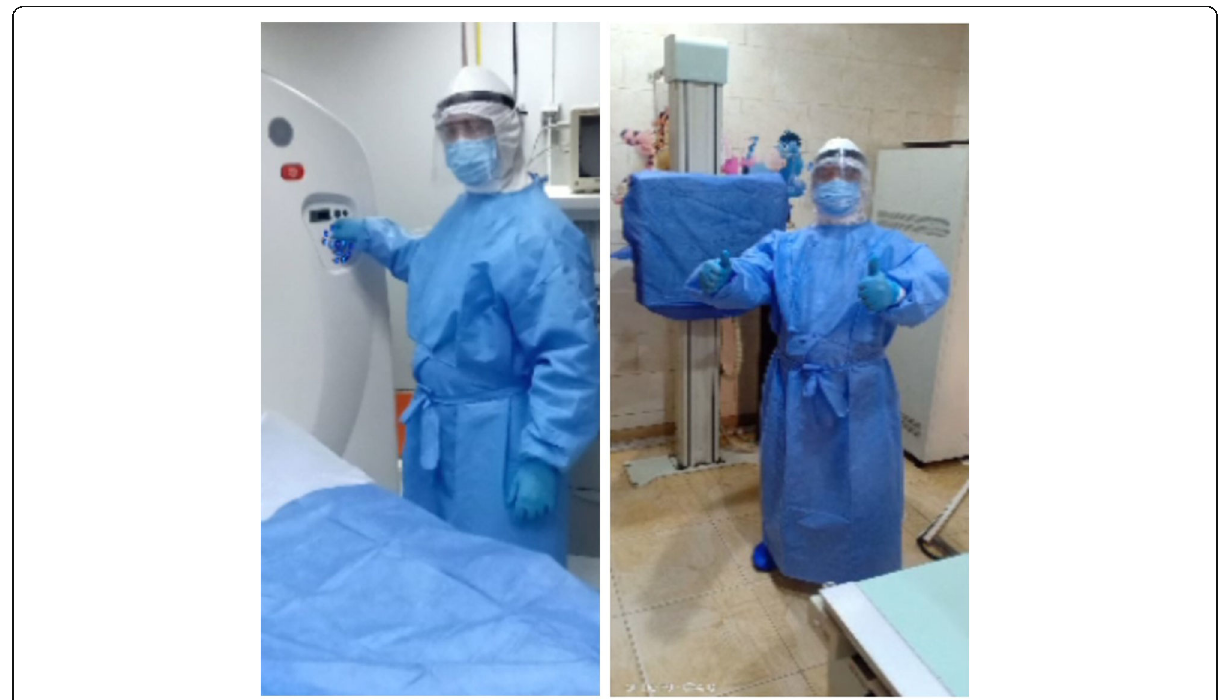
Fig. 2 Protection in the imaging rooms: a technologist is wearing PPE and standing beside the CT gantry ( a ); and X-ray bucky ( b ). The Imaging table of the CT scanner and the X-ray bucky are covered with disposable surgical